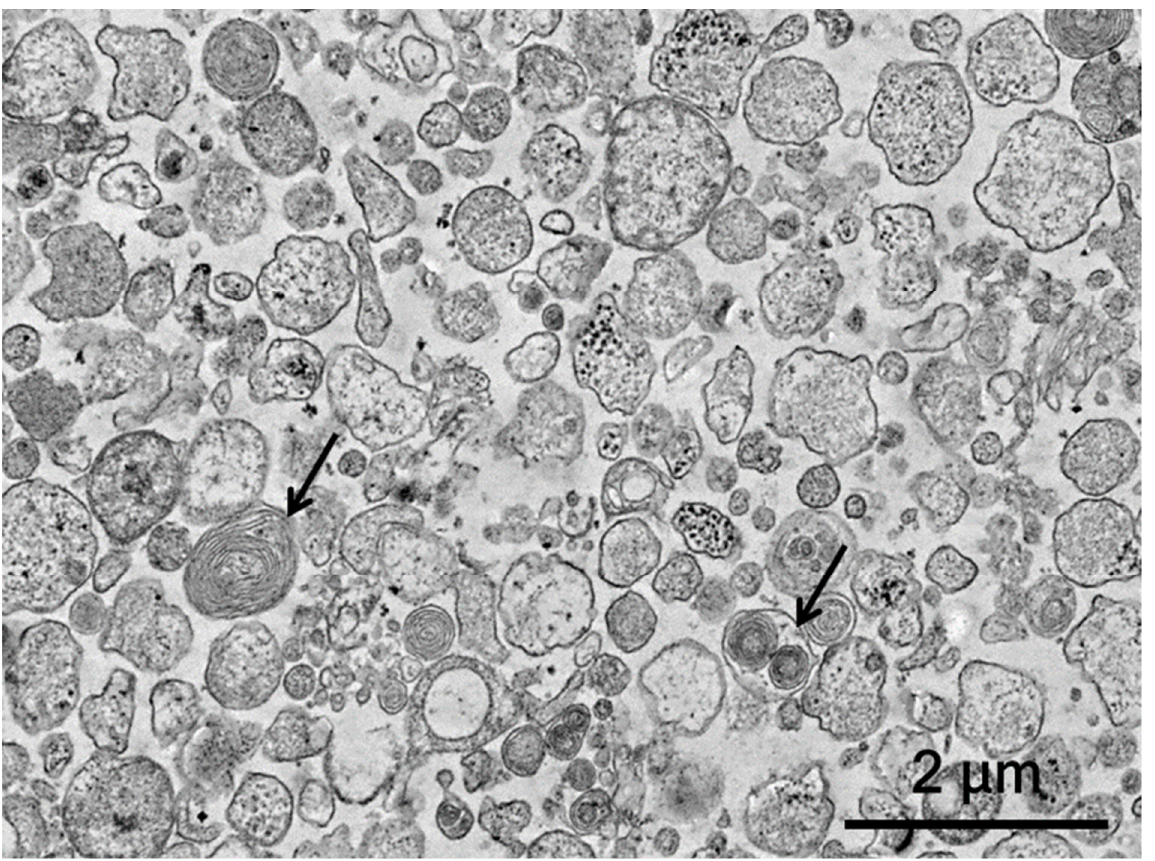
Figure 1. Analysis of the morphology of the MSC-EVs. Transmission electron microscopy was used to characterize the obtained EVs; arrows—multilamellar bodies.